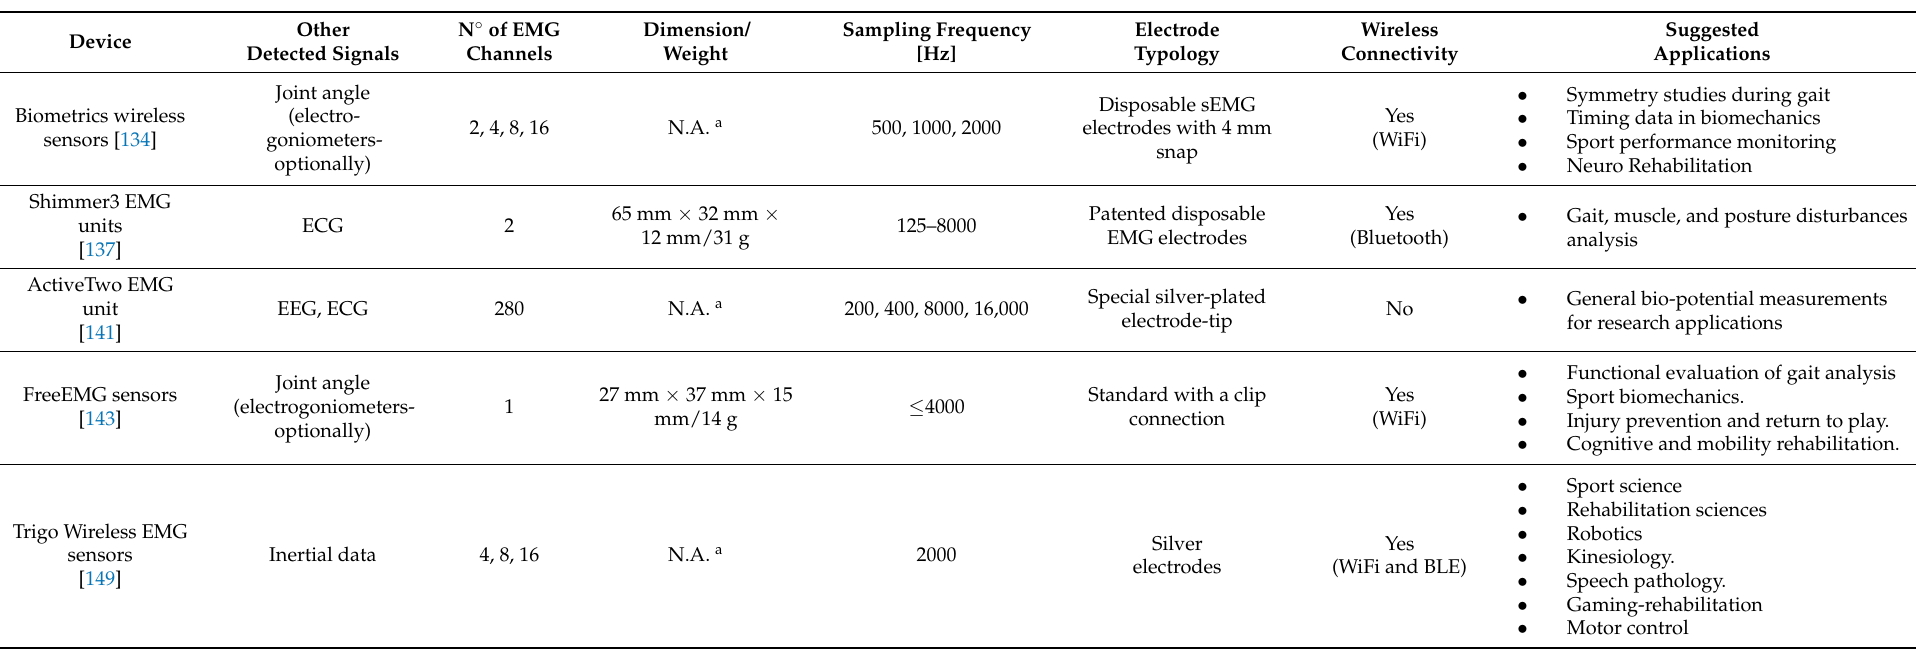
Table 2. Comparison between the commercial devices previously discussed from the perspectives of additional acquired signal, number of channels, dimension, weight, sampling frequency, electrode typology, availability of wireless connectivity, and suggested